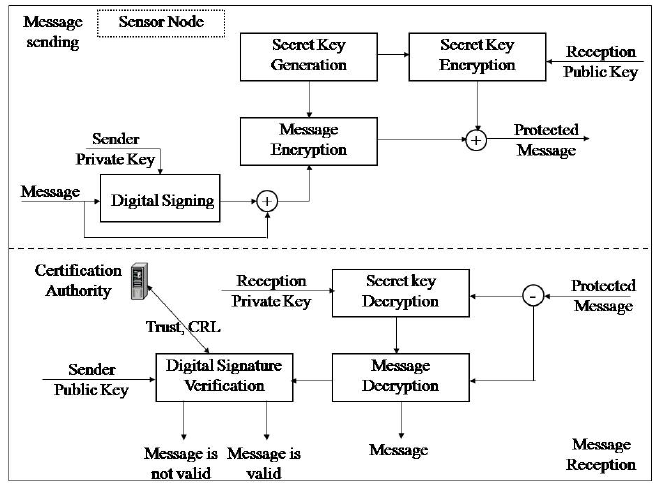
Figure 1. Wireless Sensor Network in Agriculture Protection